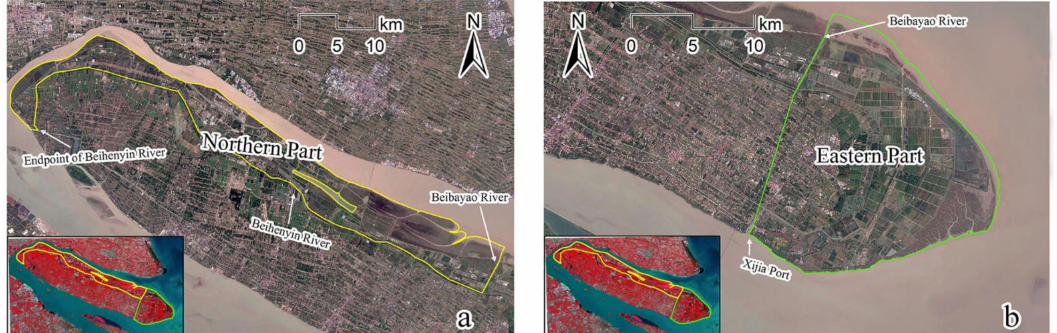
Figure 2. The northern ( a ) and eastern ( b ) parts of Chongming Island. The image is a true- color composite downloaded from Google Earth with a spatial resolution of 17.8 m, obtained on 31 December 2020; the background image in the left bottom is a Landsat OLI image obtained on 9 March 2020, with standard false color composition (near-infrared band in red, red band in green, and green band in blue); the dividing line is the shoreline extraction from the SWIR1 band of the Landsat OLI image, obtained on 16 August